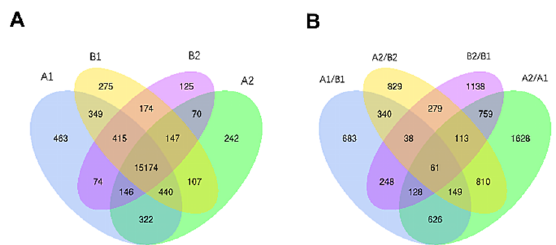
Figure 3. Venn analysis of differentially expressed genes. Annotation: ( A ) A1 represents A144 material stored for 0 days; A2 represents A144 material stored for 3 days; B1 represents A361 material stored for 0 days; B2 represents A361 material stored for 3 days. ( B ) A1/B1 means A1 compared to B1; A2/B2 means A2 compared to B2; B2/B1 means B2 compared to B1; A2/A1 means A2 compared to